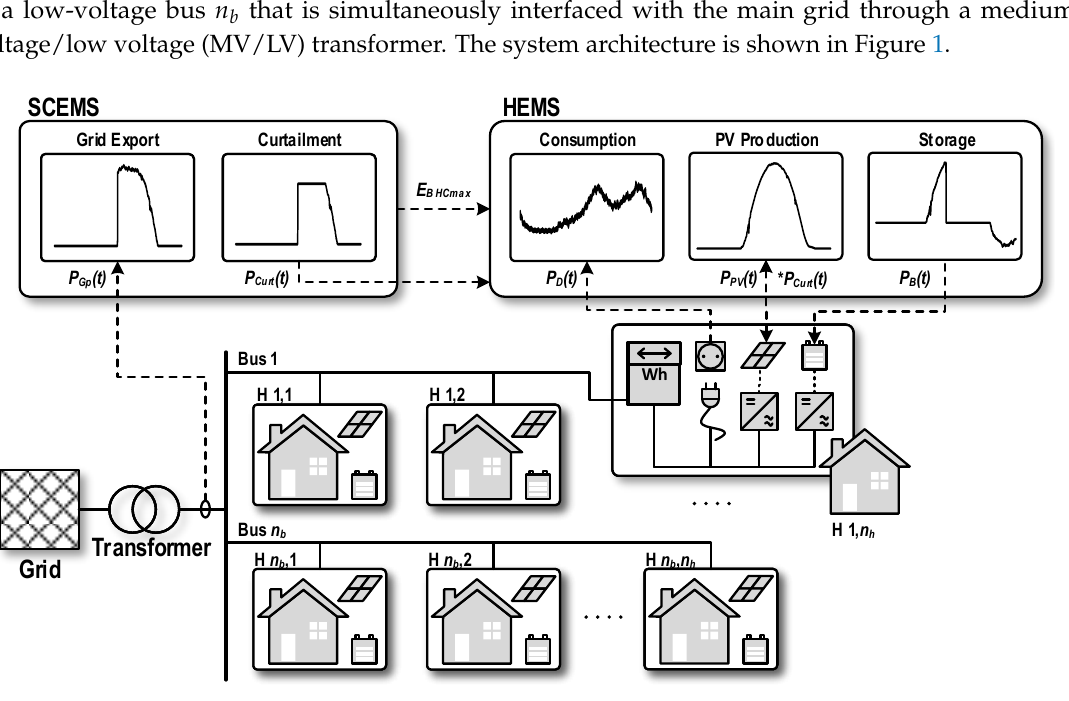
Figure 1. Conceptual architecture of the modeling and simulation system. HEMS, home